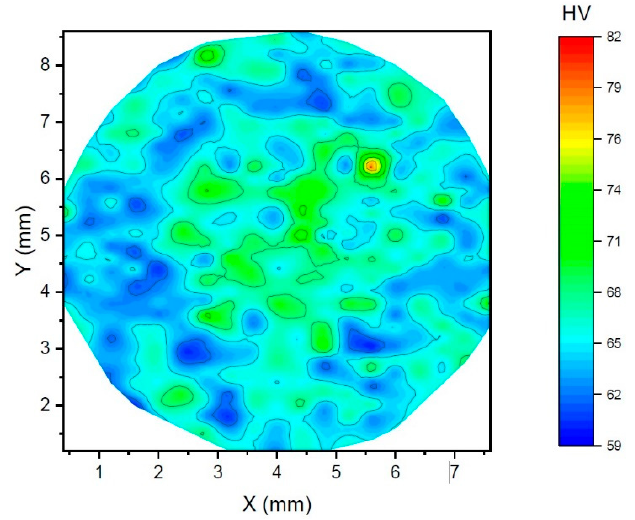
Figure 6. Microhardness map taken from the perpendicular section of the sample.